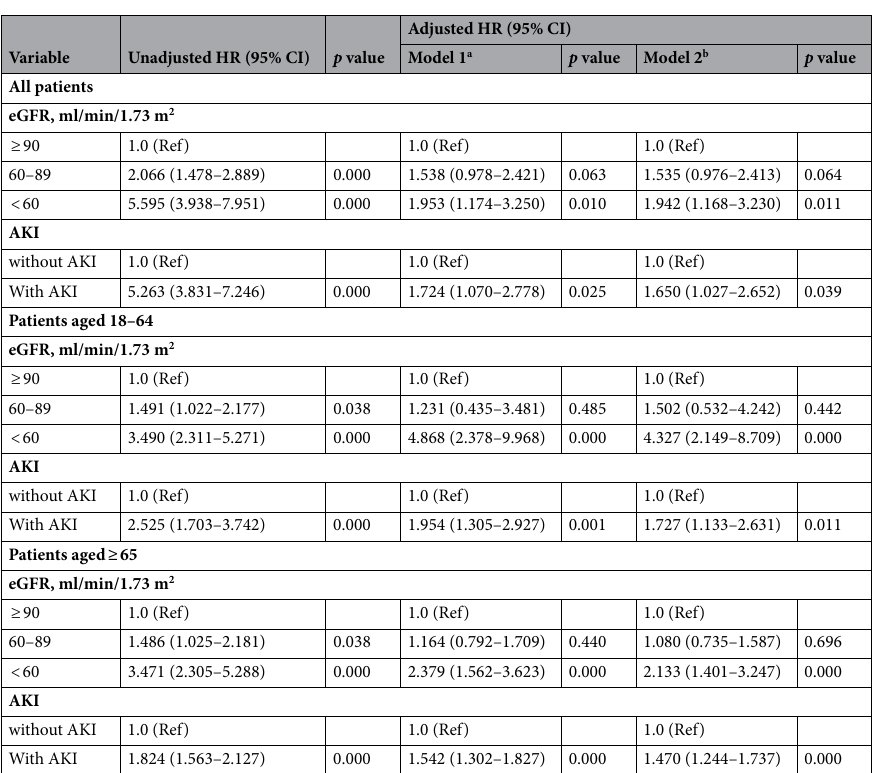
Table 5. Multivariate Cox regression analysis of associations of baseline eGFR and in-hospital AKI with the composite endpoint in patients with COVID-19. a Model 1: adjusted for disease severity, hypertension, diabetes, coronary artery heart disease, cerebrovascular disease, leukocyte count, lymphocyte count, and IL-6. b Model 2: adjusted for disease severity, hypertension, diabetes, coronary artery heart disease, cerebrovascular disease, leukocyte count, lymphocyte count, IL-6 and any complication (excluding AKI). Composite endpoint comprised admission to the intensive care unit or invasive ventilation or death, whichever occurred first. COVID-19, coronavirus disease 2019; eGFR, estimated glomerular filtration rate; AKI, acute kidney injury; HR, hazard ratio; CI, confidence interval; IL,